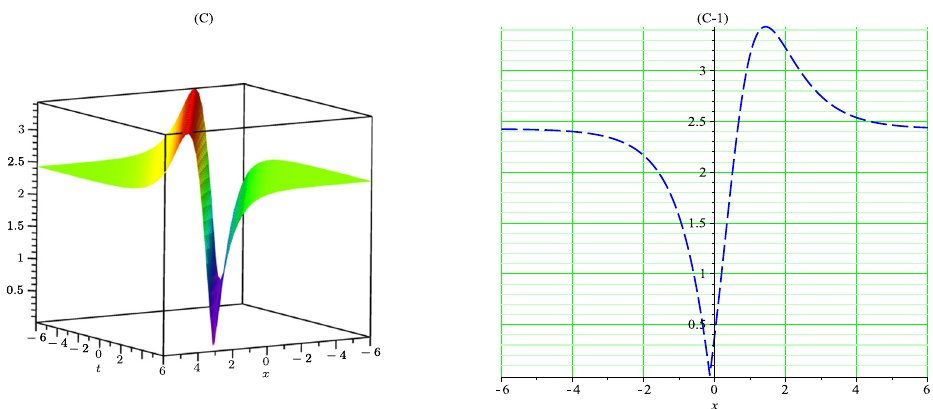
Figure 3: ( C ) 3D graph of ( 34 ) with a − 1.2 . ( C - 1 ) 2D representation of ( 34 ) with t 1 = . 1 =